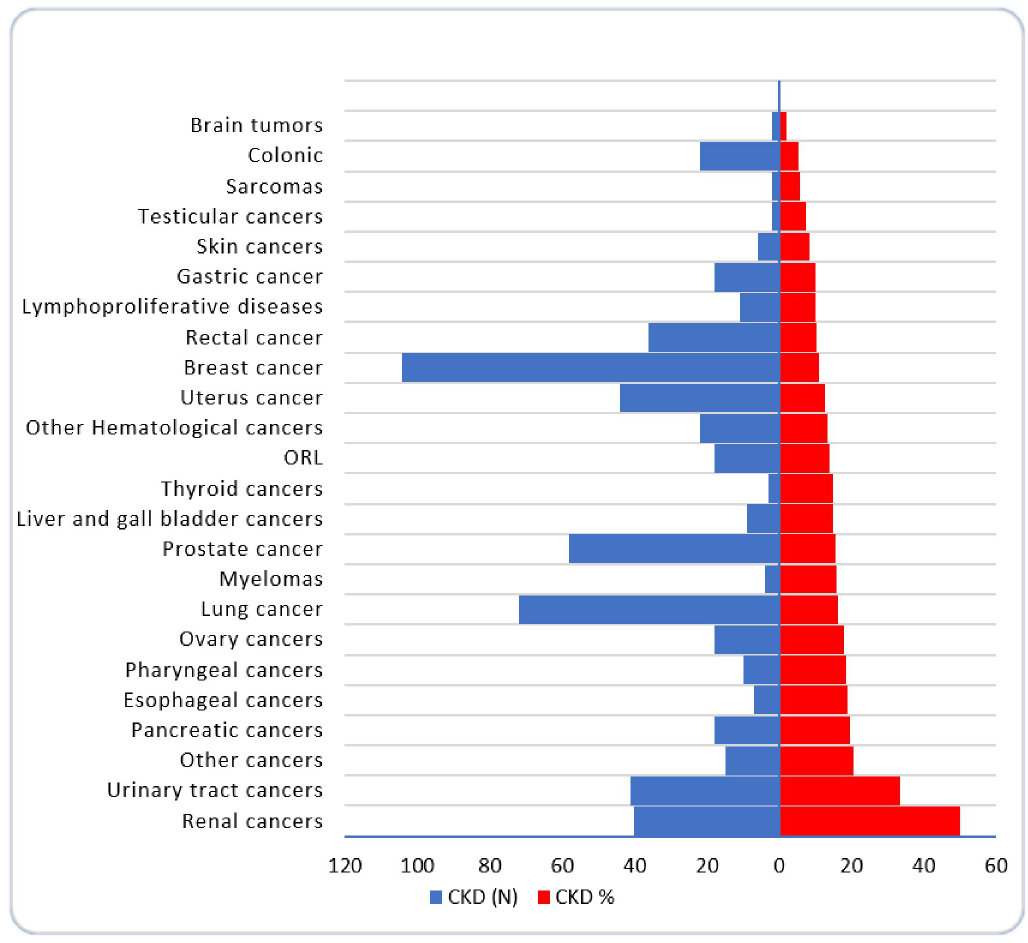
Fig 1. CKD prevalence and absolute number of CKD patients in different cancer types.